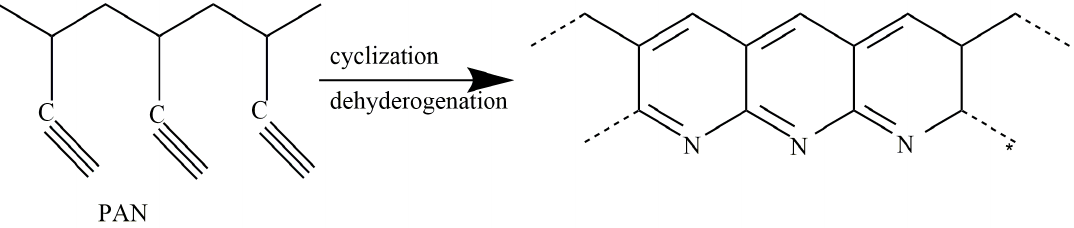
Figure 1. Schematic diagram of cyclization and dehydrogenation of polyacrylonitrile (PAN) fibers.